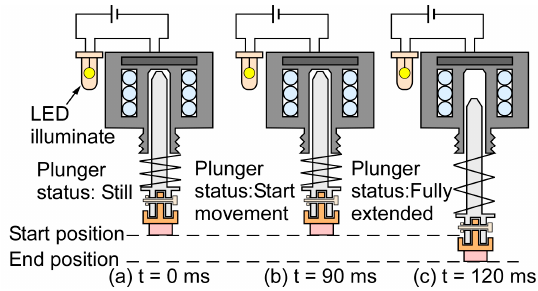
Figure 9. Dynamic response of the microvalve. ( a ) At 0 ms, the light emitting diode was turned on, confirming the passage of electric current. ( b ) At 90 ms, the plunger started to move. ( c ) At 120 ms, the plunger reached the end position.